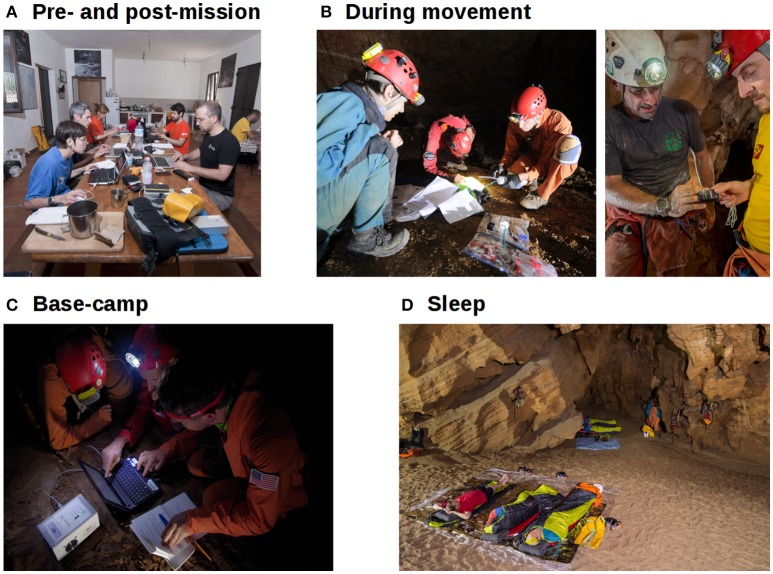
Expedition phases determine the nature of possible measurements. (A) Pre- and post-mission, testing can include delicate equipment and can be conducted in comfort. (B) During exploration, minimal portable equipment can be worn continually or used during brief stops (i.e., during photography, mapping, and rest stops); simplicity of use and robustness are key. (C) Where base-camps are established, more elaborate testing with laptops and electrophysiology can be conducted, as well as for sleep recordings during rest periods (D). Permission has been obtained from the individuals for the publication of these images. Photo credits, ESA archives, used with permission from photographers; (A), Alessio Romeo; (B), left: Alessio Romeo, right: Natalino Russo; (C), Vittorio Crobu; (D) Riccardo DeLuca.